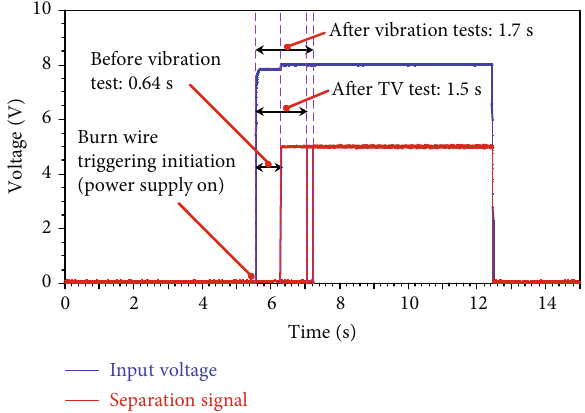
Figure 15: Time histories of release time of the mechanism before and after launch vibration and TV